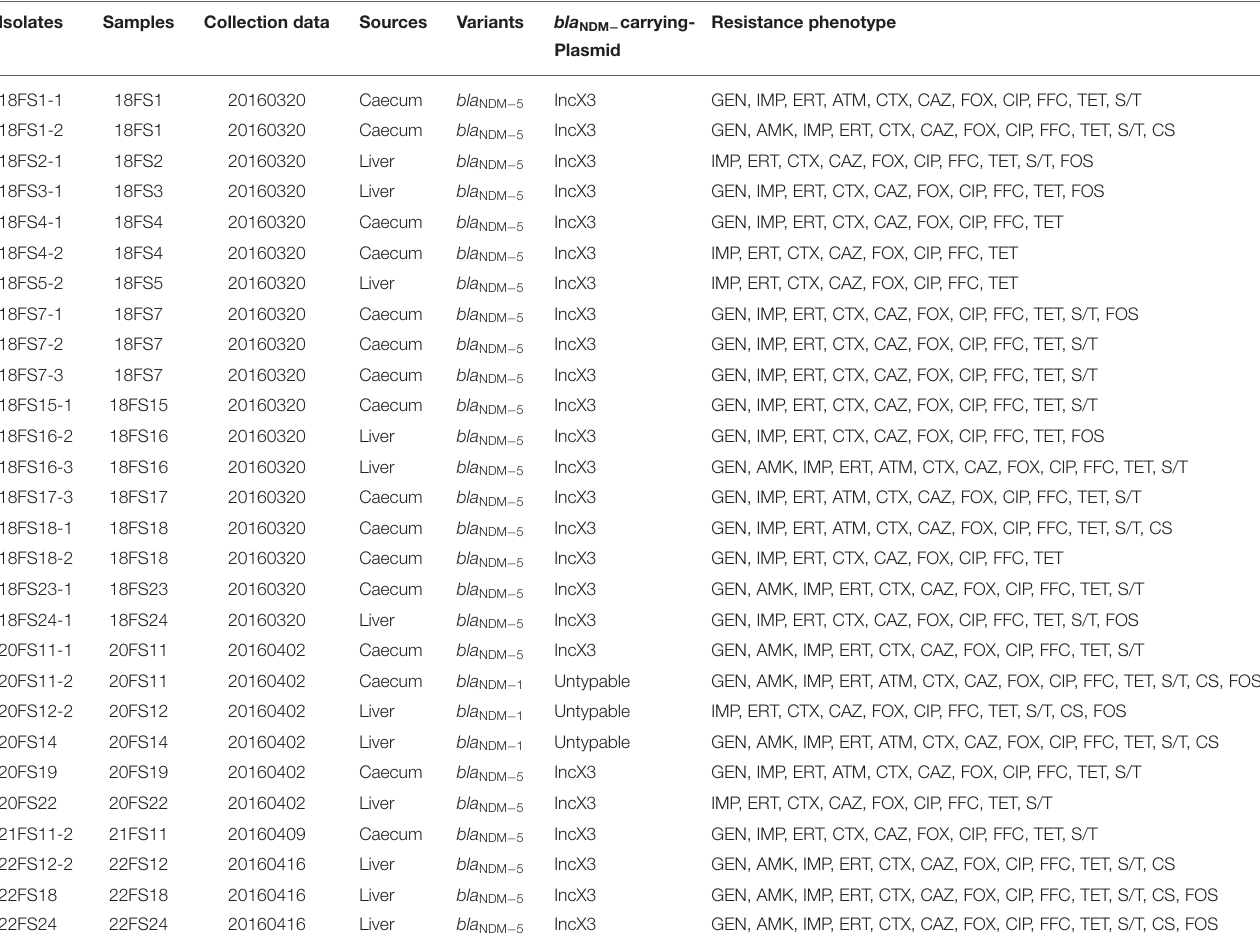
TABLE 1 | Bacterial information and antimicrobial resistance profiles. Isolates